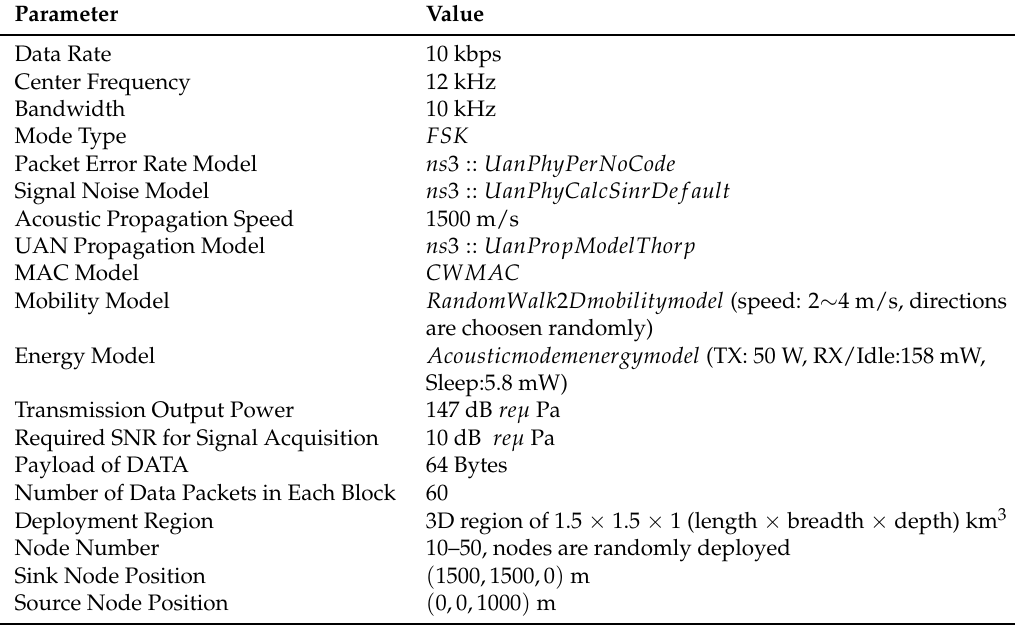
Table 1. Simulation